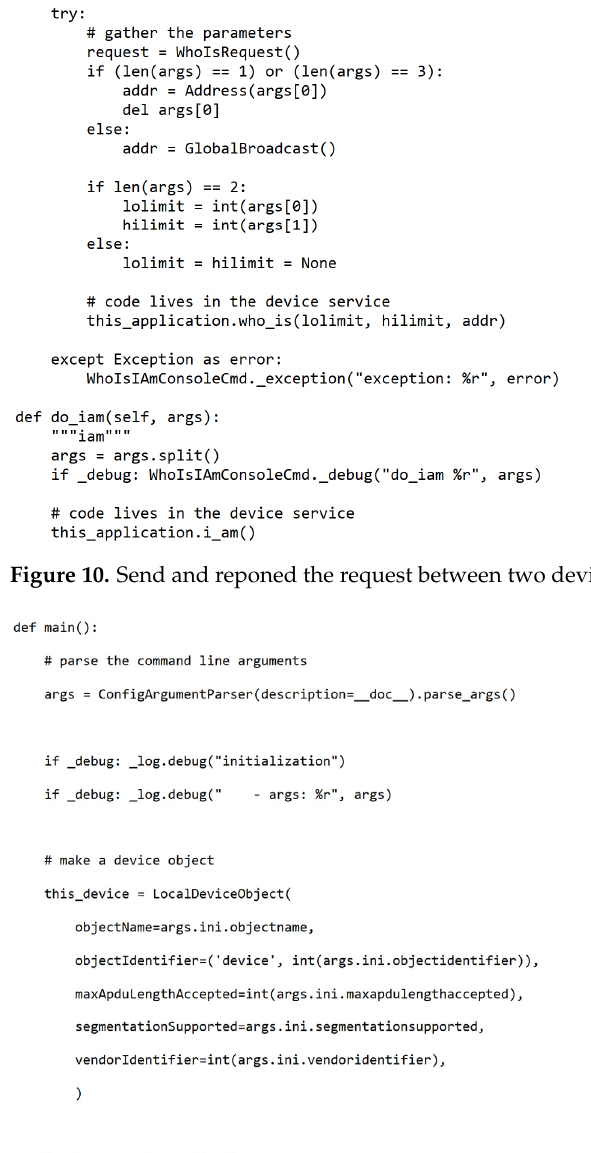
Figure 10. Send and reponed the request between two devices.